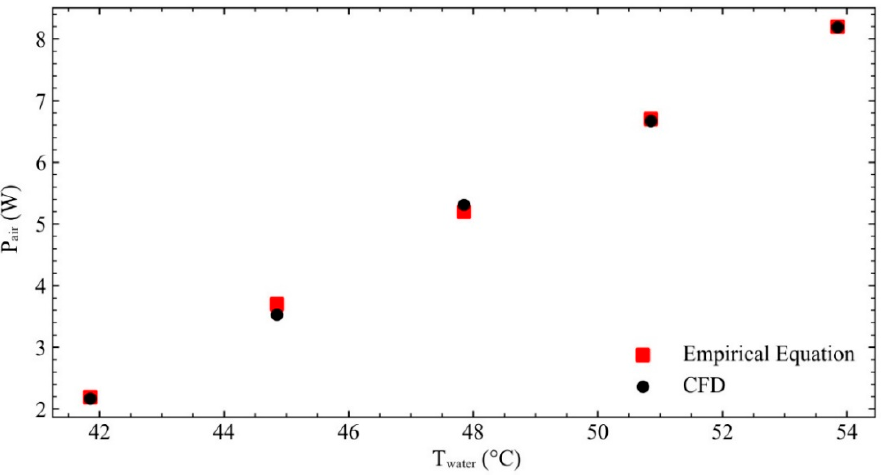
Figure 16. Comparison of the estimated and simulated results for varying water temperatures.